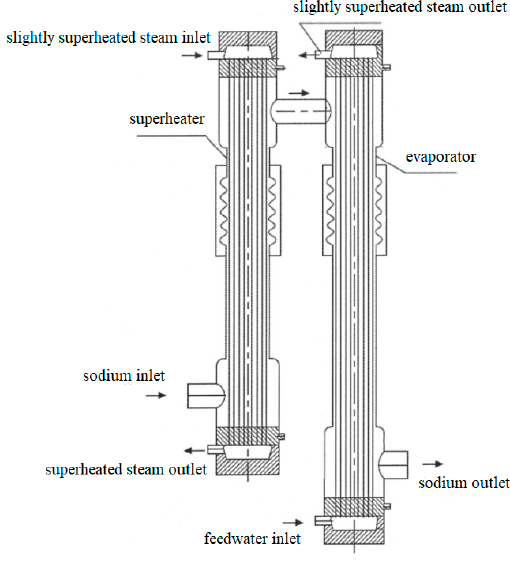
Figure 1. The prototype sodium heated OTSG.